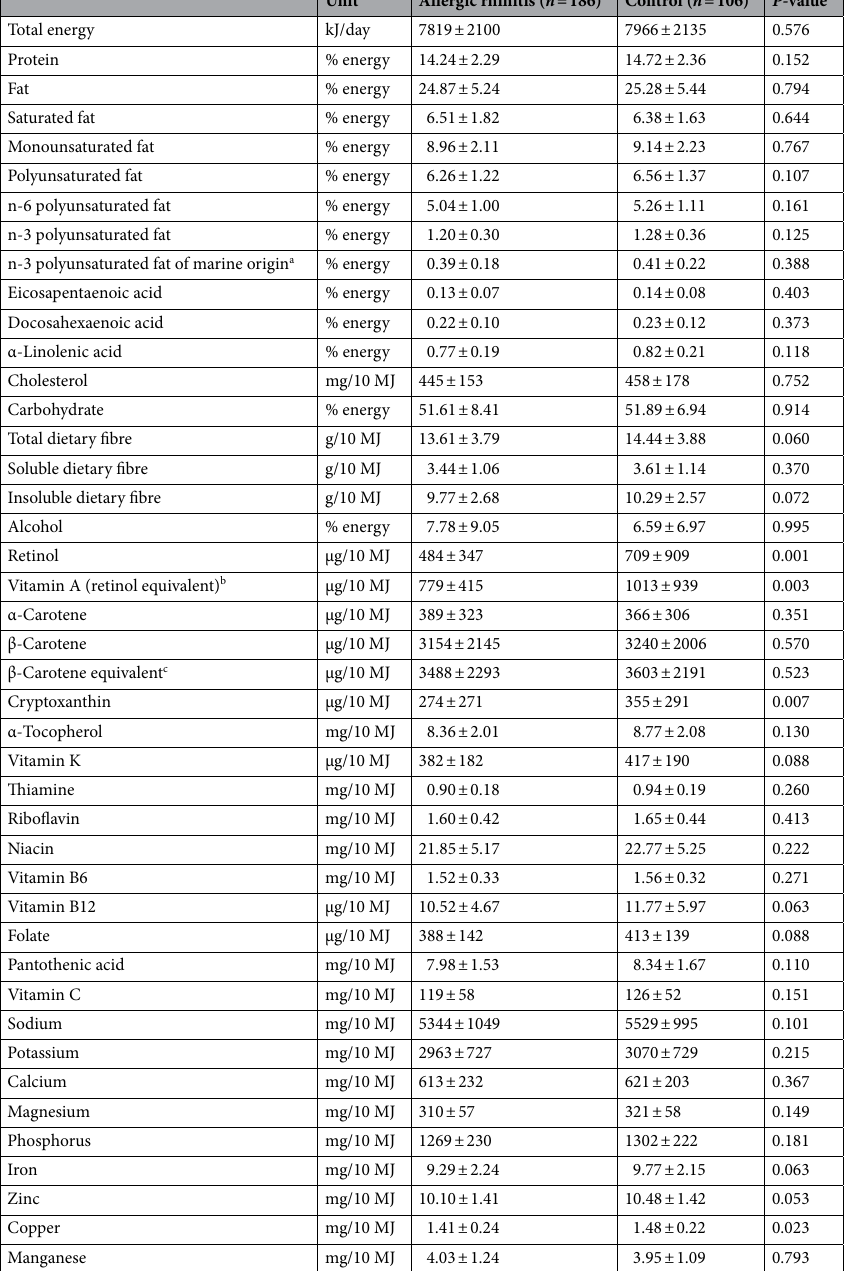
Table 2. Energy-adjusted nutrient intakes and allergic rhinitis. Values are shown as the mean ± standard deviation. P -values were calculated using the Wilcoxon rank sum test. No adjustments were made for statistical tests shown in this table. a Sum of eicosapentaenoic acid, docosapentaenoic acid, and docosahexaenoic acid 16 . b Sum of retinol, β-carotene/12, α-carotene/24, and cryptoxanthin/24 16 . c Sum of β-carotene, α-carotene/2, and cryptoxanthin/2 16